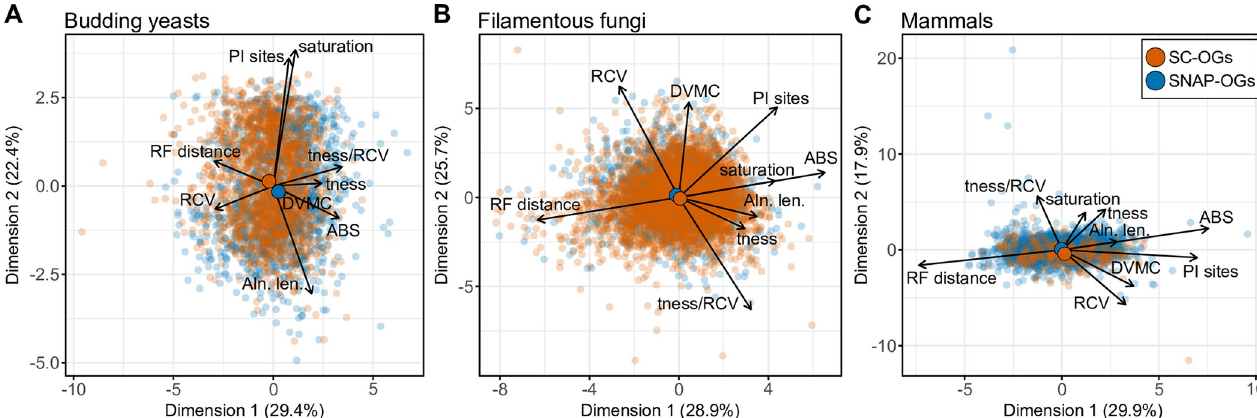
Fig 3. SC-OGs and SNAP-OGs have similar phylogenetic information content. To evaluate similarities and differences between SC-OGs (orange dots) and SNAP-OGs (blue dots), we examined each gene’s phylogenetic information content by measuring 9 properties of multiple-sequence alignments and phylogenetic trees. We performed these analyses on 12,764 gene families from 3 datasets—24 budding yeasts (1,668 SC-OGs and 1,392 SNAP-OGs) ( A ), 36 filamentous fungi (4,393 SC-OGs and 2,035 SNAP-OGs) ( B ), and 26 mammals (321 SC-OGs and 1,775 SNAP-OGs) ( C ). Principal component analysis revealed striking similarities between SC-OGs and SNAP-OGs in all 3 datasets. For example, the centroid (i.e., the mean across all metrics and genes) for SC-OGs and SNAP-OGs, which is depicted as an opaque and larger dot, are very close to one another in reduced dimensional space. Supporting this observation, multifactor analysis of variance with interaction effects of the 6,630 SNAP-OGs and 6,634 SC-OGs revealed no difference between SC-OGs and SNAP-OGs ( p = 0.63, F = 0.23, df = 1) and no interaction between the 9 properties and SC-OGs and SNAP-OGs ( p = 0.16, F = 1.46, df = 8). Multifactor analysis of variance using an additive model yielded similar results wherein SC-OGs and SNAP-OGs do not differ ( p = 0.65, F = 0.21, df = 1). There are also very few outliers of individual SC-OGs and SNAP-OGs, which are represented as translucent dots, in all 3 panels. For example, SNAP-OGs outliers at the top of panel C are driven by high treeness/RCV values, which is associated with a high signal-to-noise ratio and/or low composition bias [23]; SNAP-OG outliers at the right of panel C are driven by high average bootstrap support values, which is associated with greater tree certainty [74]; and the single SC-OG outlier observed in the bottom right of panel C is driven by a SC-OG with a high degree of violation of a molecular clock [78], which is associated with lower tree certainty [79]. Multiple-sequence alignment and phylogenetic tree properties used in principal component analysis and abbreviations thereof are as follows: average bootstrap support (ABS), degree of violation of the molecular clock (DVMC), relative composition variability, Robinson–Foulds distance (RF distance), alignment length (Aln. len.), the number of parsimony informative sites (PI sites), saturation, treeness (tness), and treeness/RCV (tness/RCV). The data underlying this figure can be found in figshare (doi: